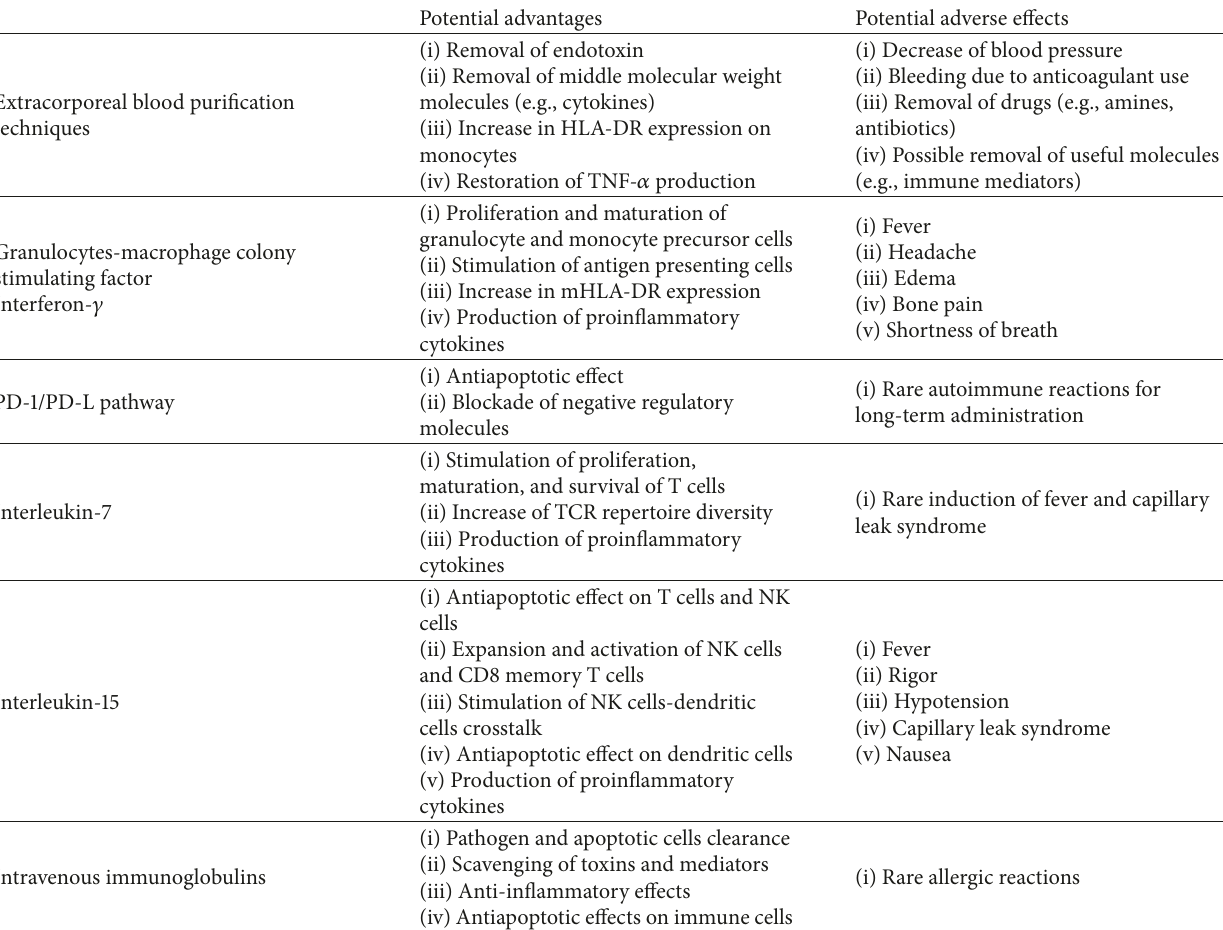
Table 1: The rationale and the possible adverse reactions of adjunctive immune-modulatory therapies in patients with sepsis. Potential